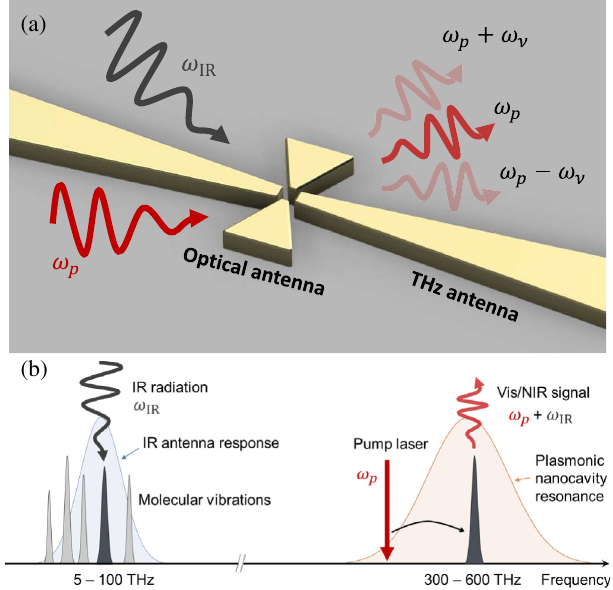
FIG. 1. (a) Illustration of the envisioned upconversion device. Both electromagnetic modes are collected with the help of the dual antenna and confined within a volume where molecules are located. (b) Frequency picture of the optomechanical conversion mechanism involving both IR absorption and Raman scattering by specific vibrational modes. Here, the pump tone ( ω red-detuned from the optical resonance ( ω the incoming IR signal is resonant with a specific vibrational ω mode ( ω ν IR ¼